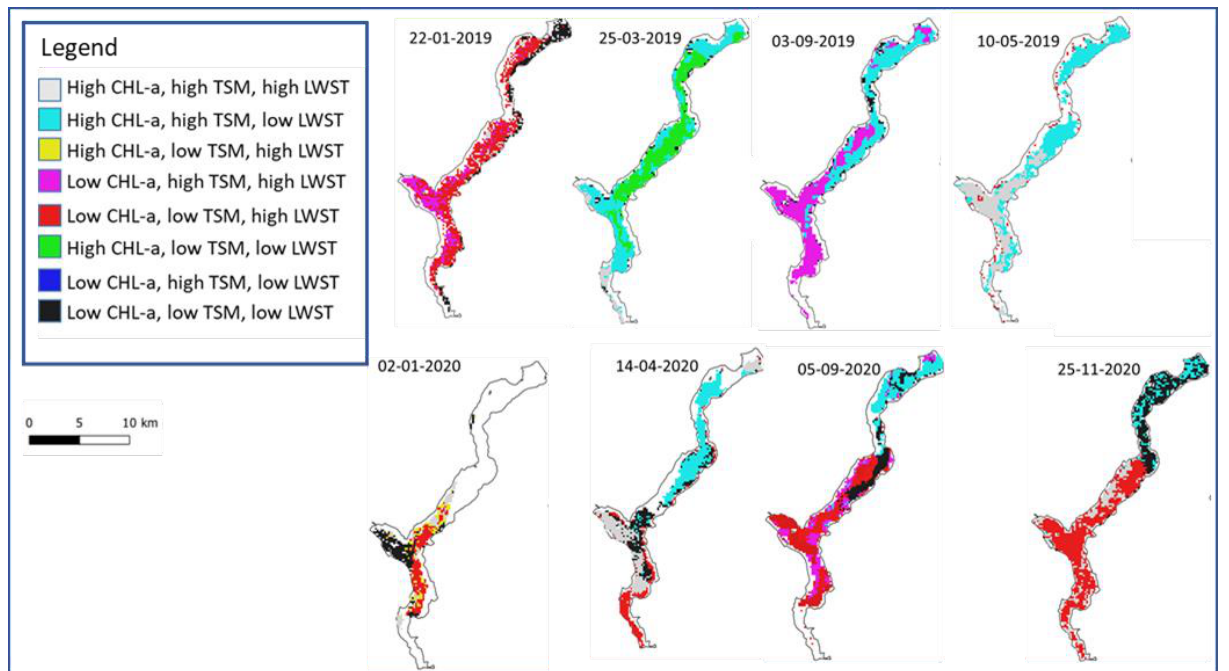
Figure 7. Time series clusters for Lake Maggiore for years 2019-2020. Position of lake cluster maps is due to the date they are referred to. Clusters are represented with RGB composition linked to clusters mean WQPs values (Red channel represents LWST, Green CHL-a, Blue